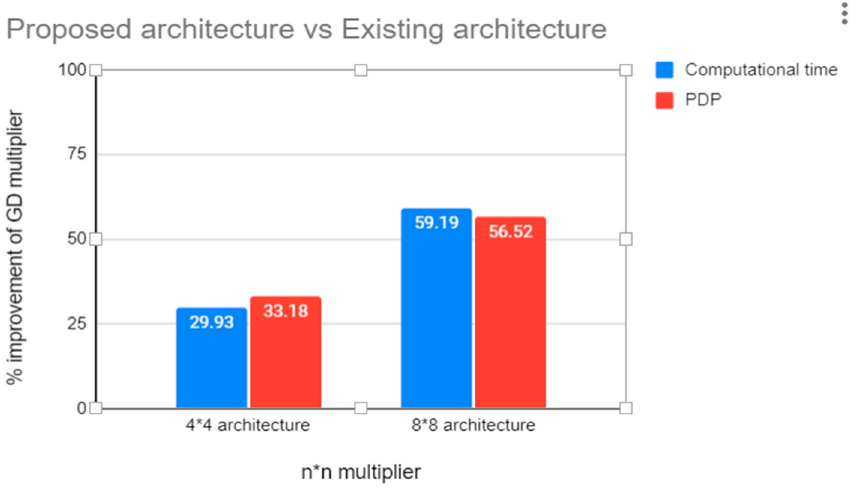
Figure 9. Proposed multiplier vs. existing multiplier.